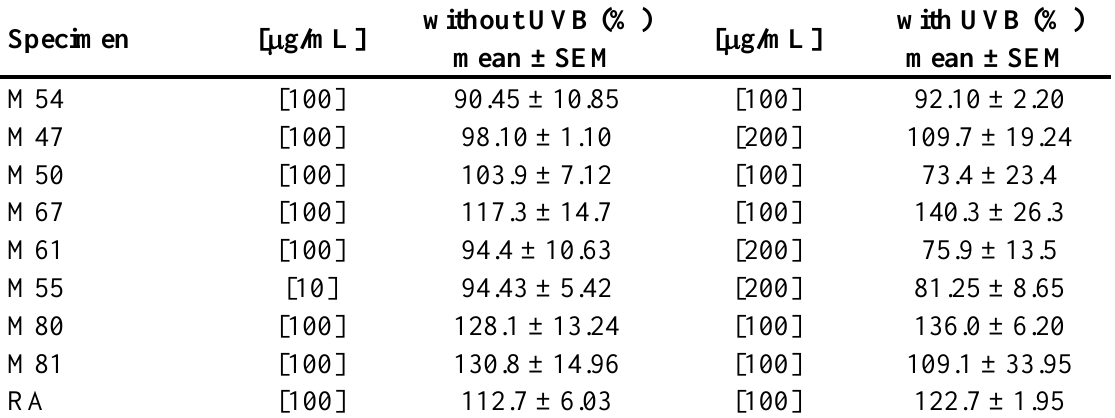
Table 2. Effect of Taiwanese Plants on cell viability on WS-1